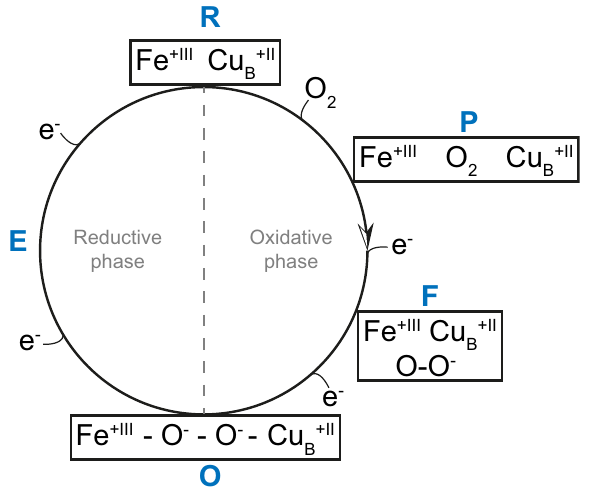
Fig. 9 A potential catalytic cycle of C c O based on our results. The classical P -state is an oxygenated oxidized form of C c O. Input of one electron reduces the bound dioxygen to superoxide which remains bound in the BNC near Cu B (classical F -state). Input of another electron reduces the superoxide to a peroxide which forms a bridging ligand in the BNC of the O -state. The next input of an electron leads to the formation of the classical E -state whose structure is still unknown. Input of the fourth electron leads to the formation of a 2-electron R -state which binds a dioxygen molecule closing the cycle. Two water molecules or one water molecule plus one hydroxide ion are formed during the input of the third and fourth electrons in the classical reductive